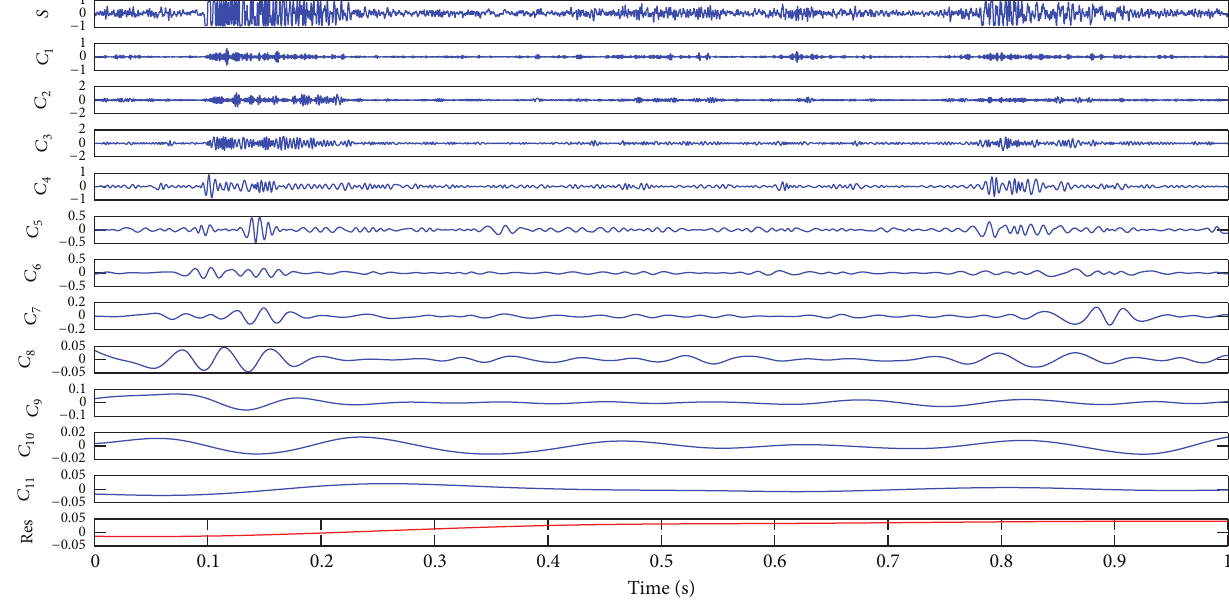
Figure 3: EMD results for